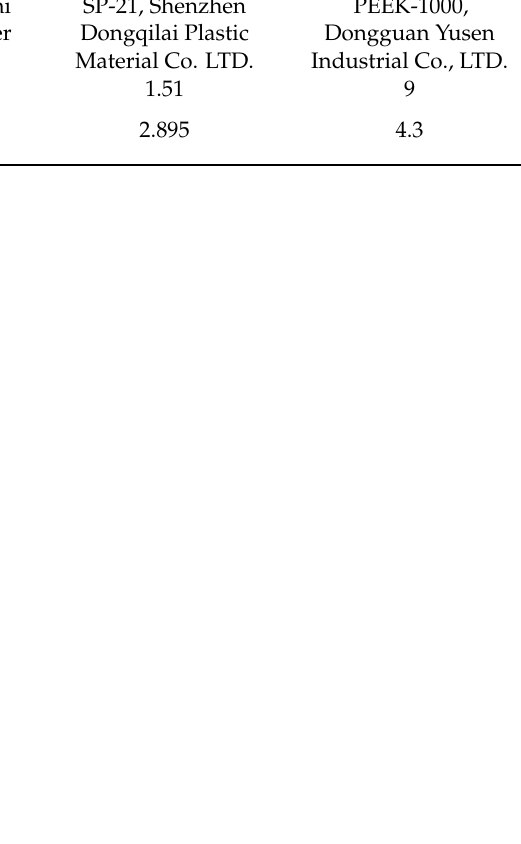
Figure 1. Chemical structures of poly(methyl methacrylate) (PMMA), polyetheretherketone (PEEK) and polyimide (PI). Table 1. Mechanical properties of polymers used in this work.